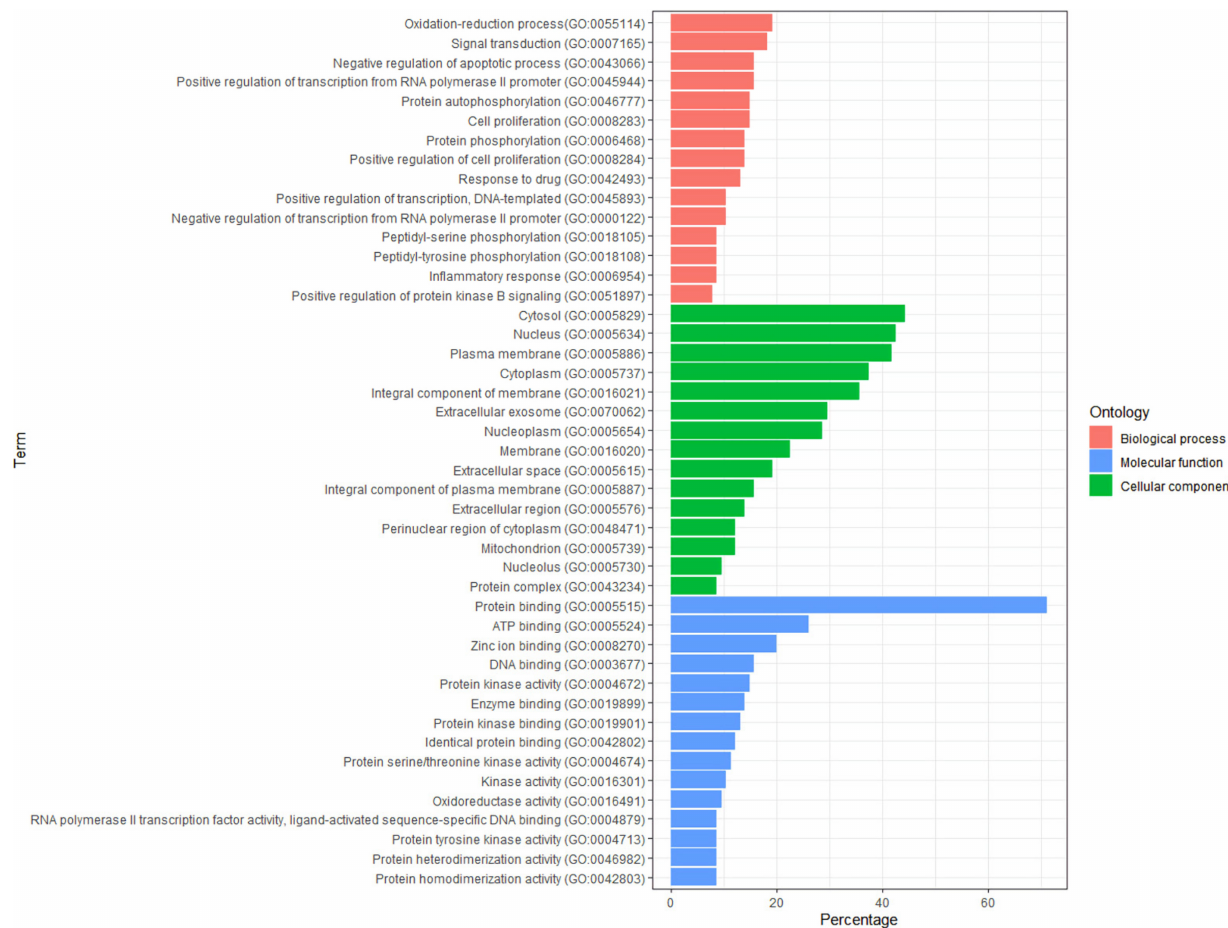
Figure 4. The GO analysis of key targets. The KEGG pathway analysis returned 74 items, and we selected the top 20 for a visual analysis based on gene count number rank (Figure 5). The analysis revealed that these targets were predominantly enriched in pathways in cancer, proteoglycans in cancer, focal adhesion, insulin resistance, and adherens